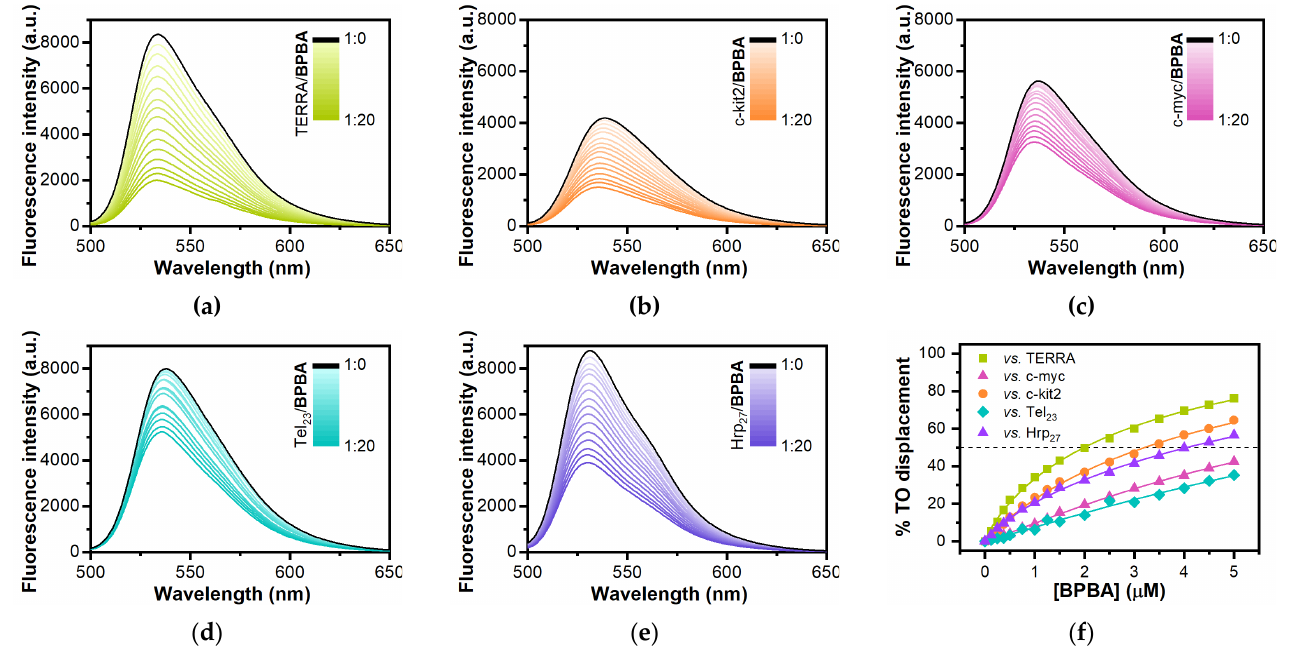
Figure 4. TO displacement titrations for ( a ) TERRA G4 , ( b ) c-kit2 G4 , ( c ) c-myc G4, ( d ) Tel 23 G4, and ( e ) Hrp 27 upon addition of increasing amounts of BPBA ; ( f ) Dose–response curves from FID experiments.